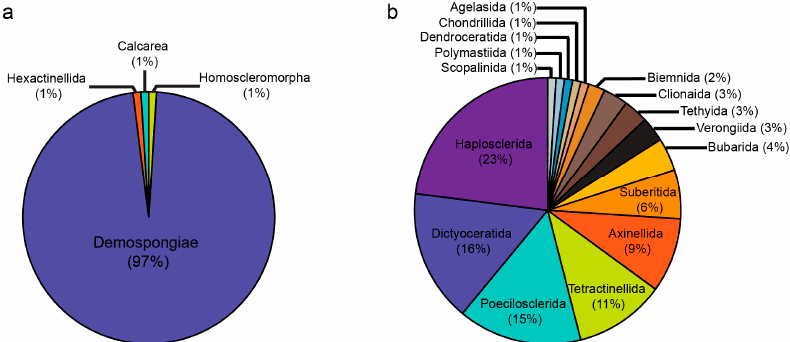
Figure 2. Proportions of higher sponge taxa across 1164 species and OTUs distinguished in the study (Pilbara region). ( a ) Sponge classes; ( b ) Sponge orders within Demospongiae. Values were rounded off to the nearest percentage.